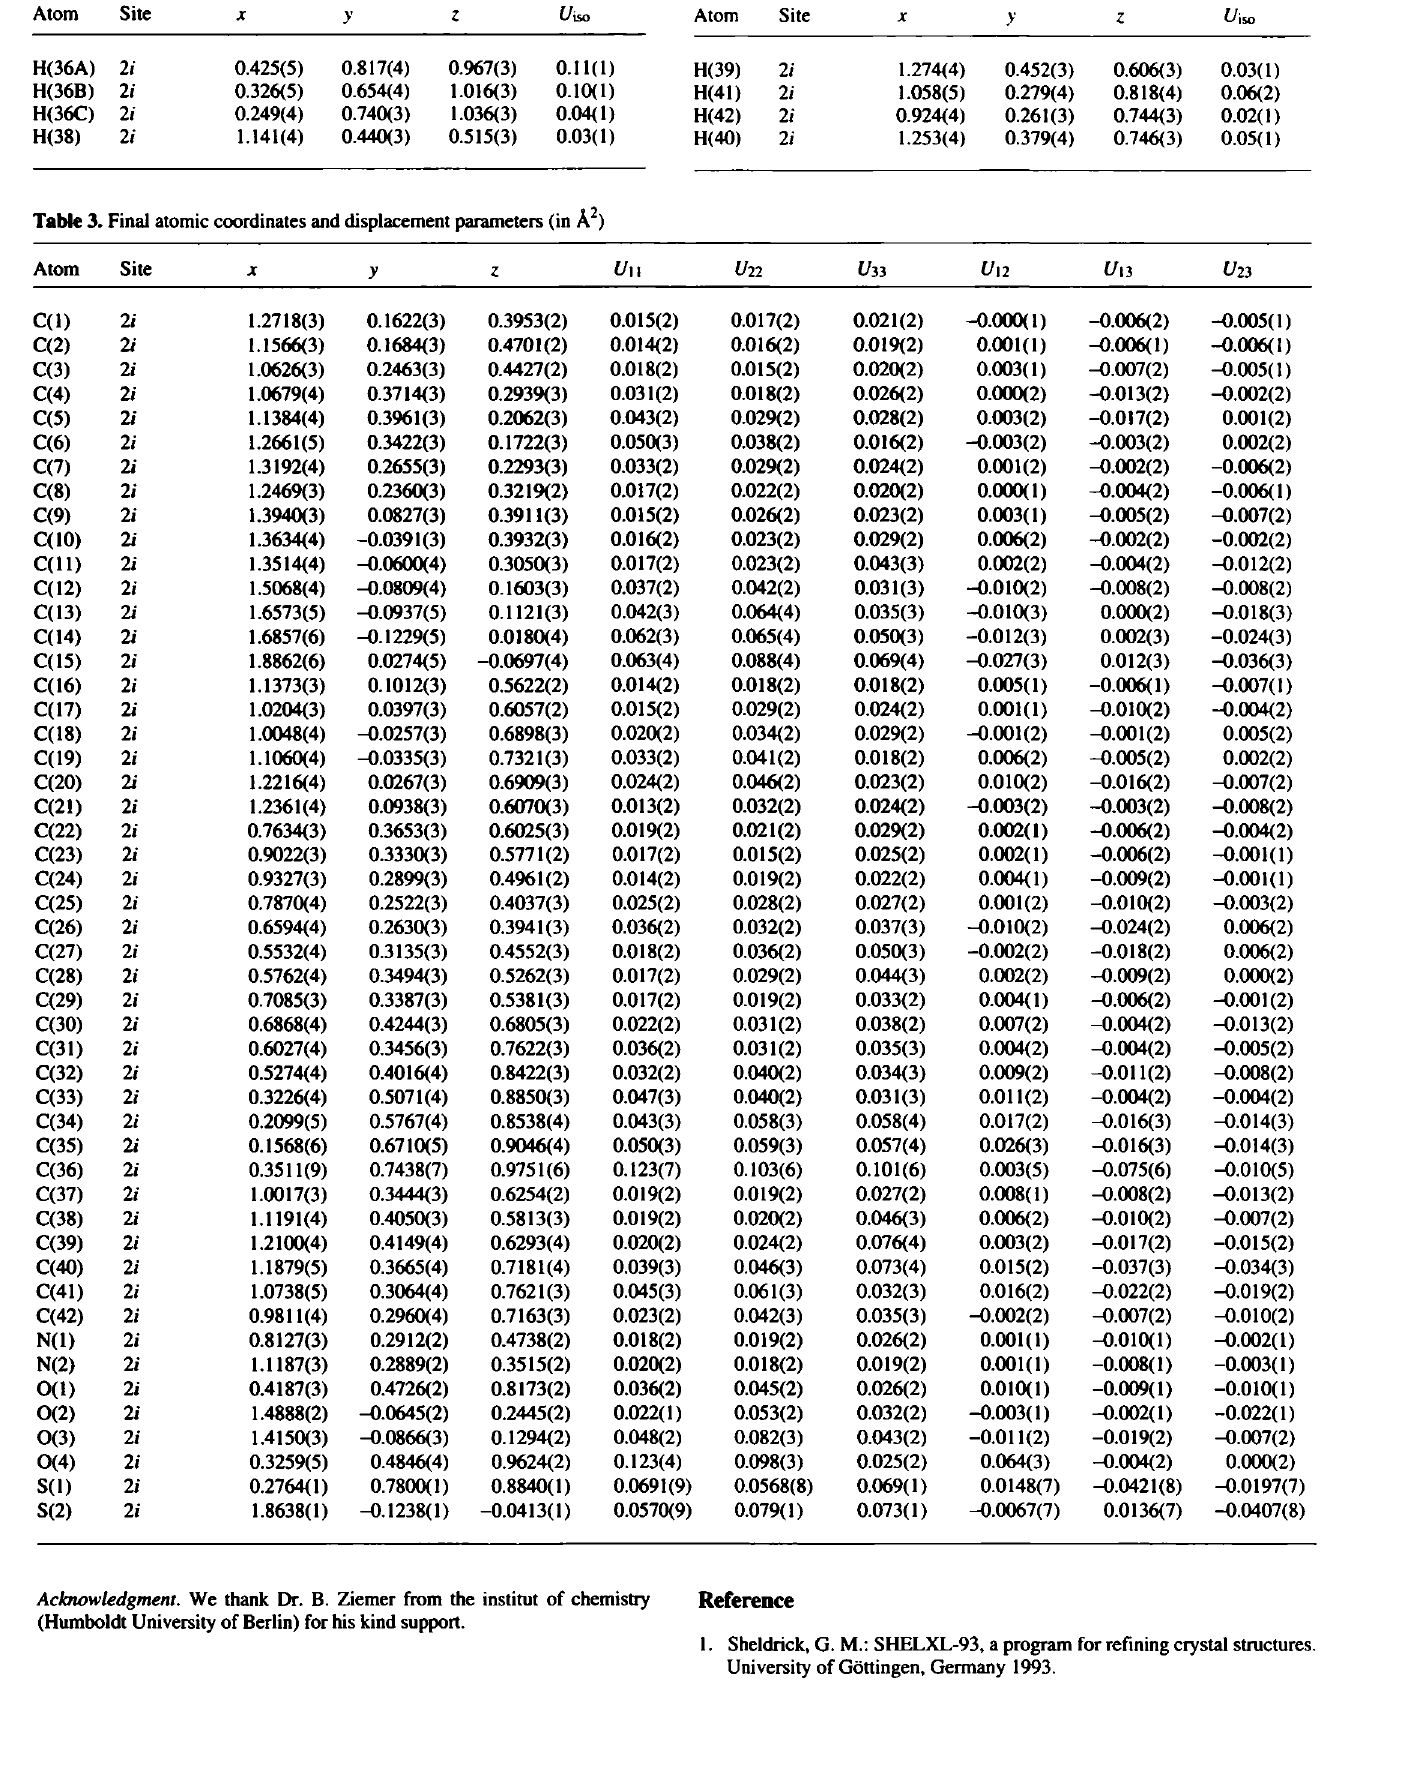
Table 3. Final atomic coordinates and displacement parameters (in A 2